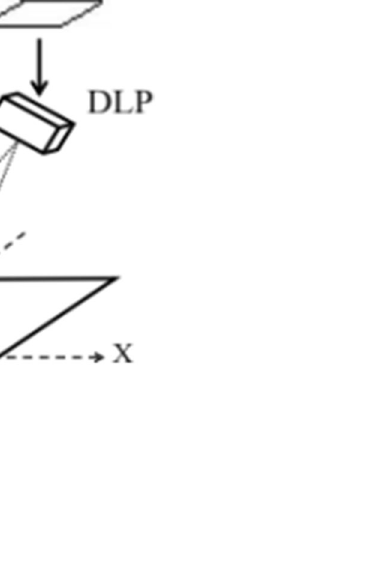
Figure 1. The setup of